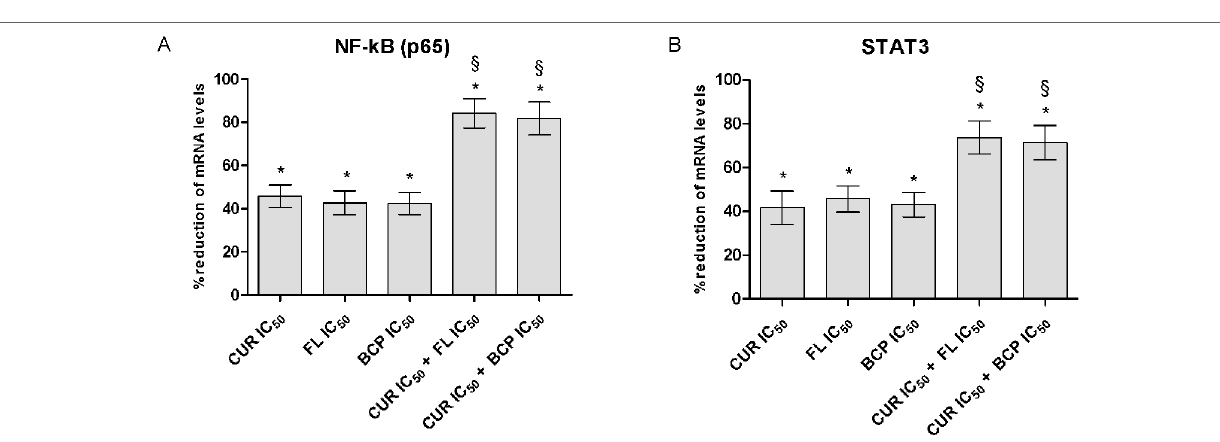
FIgURE 8 | NF-kB (panel A ) and STAT3 (panel B ) mRNA expression evaluated by RTqPCR. Data are expressed as % of reduction of mRNA levels vs LPS. Values are expressed as the mean ± SD. * p < 0.001 versus LPS (not shown); § p < 0.001 versus LPS + CUR (curmin) IC 50 , LPS + FL (flavocoxid) IC 50 and LPS + BCP (β-caryophyllene) IC 50 .